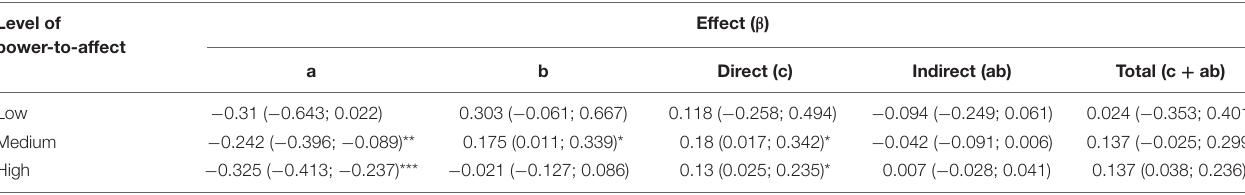
TABLE 5 | Latent variable: Level of power-to-affect.